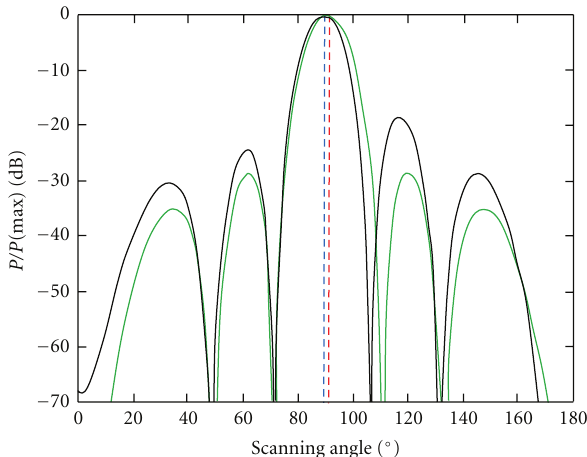
Figure 15: The beam pattern of the antenna array with 0 degree of interference.